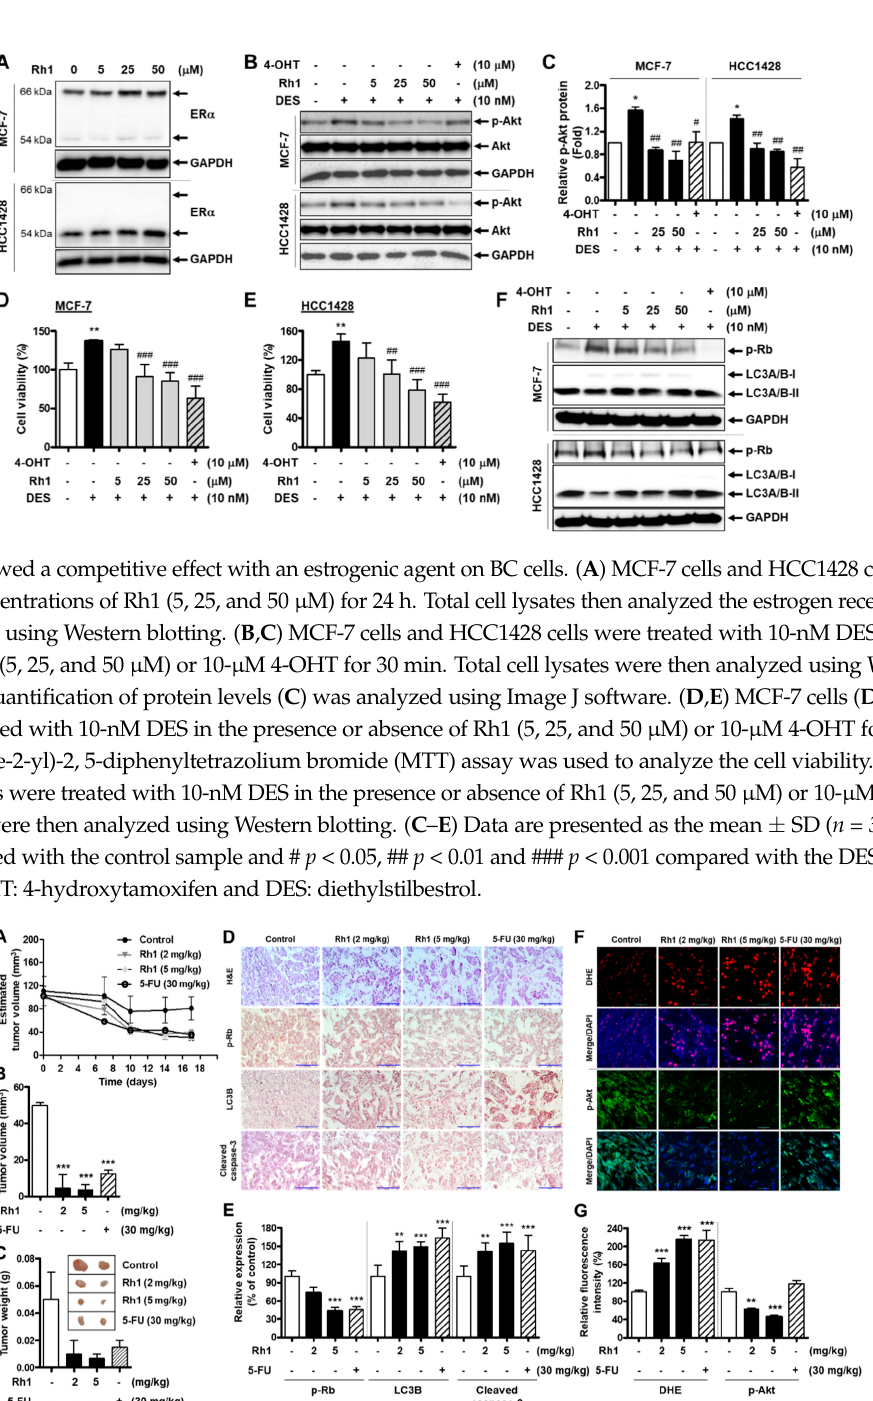
Figure 7. Rh1 exerted antitumor activities in a xenograft model. ( A ) Estimated tumor volumes were measured every three days after the implantation using caliper measurements and calculated with the following formula: volume = 0.5 × (length × width 2 ). ( B , C ) Sixteen days after the administration of Rh1 (2 and 5 mg/kg), 5-FU (30 mg/kg), or DMSO, the xenograft tumors were collected; the average ± SD tumor volume ( B ) and tumor weight ( C ) were analyzed. ** * p < 0.001 compared with the control sample. The images showed the tumors generated by different groups ( C ). ( D ) Hematoxylin and eosin staining (upper panel) and an immunohistochemistry analysis of p-Rb, LC3B, and cleaved caspase-3. Scale bar indicates 100 µm. ( E ) Quantified bar graph indicates p-Rb, LC3B, and cleaved caspase-3 expression in tumor tissues. ( F ) Dihydroeth- idium (DHE) staining (two upper panels) and immunofluorescence staining of Akt phosphorylation (two lower panels) in tumor tissues. ( G ) Quantified bar graph indicates the relative fluorescence levels of DHE and Akt phosphorylation expression in tumor tissues. ( A – C , E , G ) Data are expressed as the mean ± SD ( n = 5), * * p < 0.01 and ** * p < 0.001 as compared with the control. 5-FU: 5-fluorouracil and DMSO: dimethyl sulfoxide.